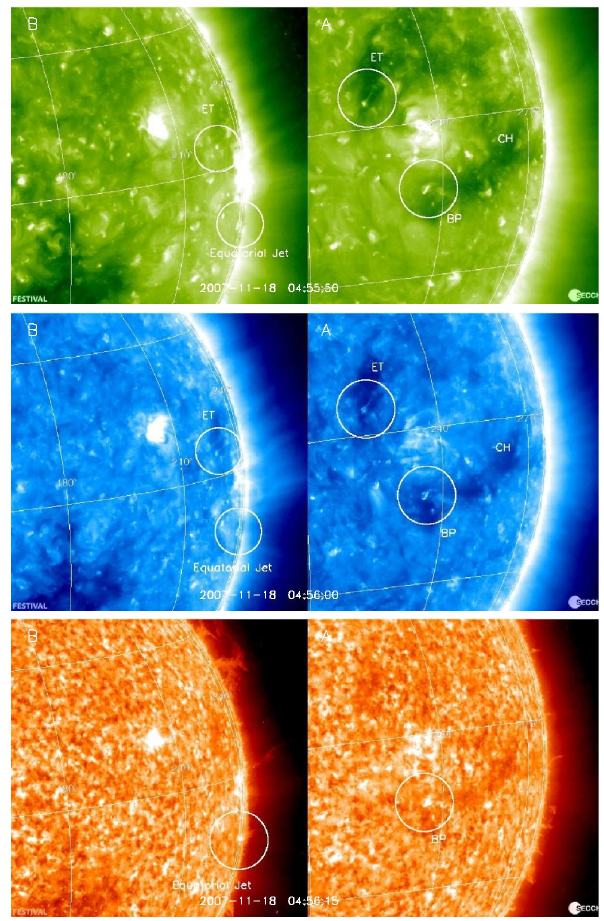
Fig. 7. STEREO B and A images at 195, 171 and 304 ˚A for the equatorial jet observed on 18 November